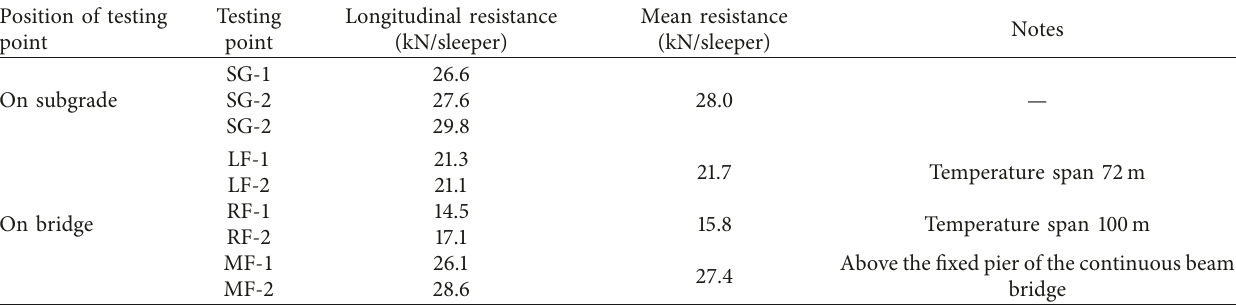
Figure 10: Ballast longitudinal resistance-displacement curves (a) on the subgrade and (b) on the bridge. Table 2: Tested ballast longitudinal